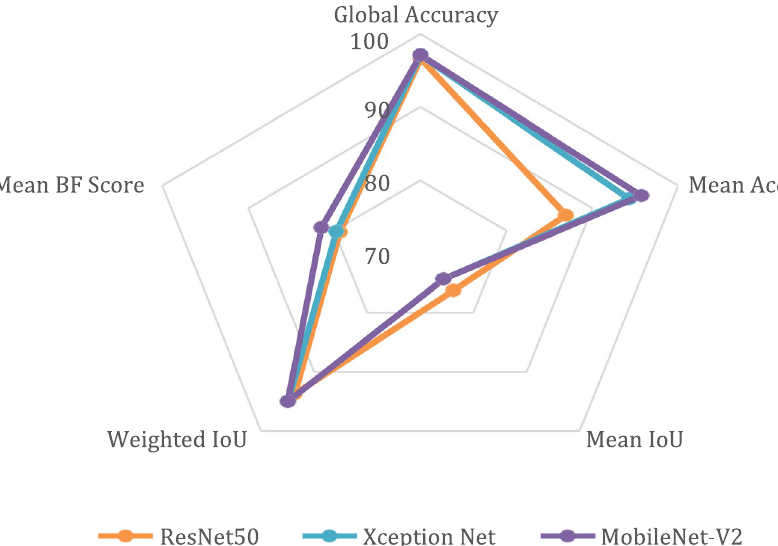
Fig. 13 The radar plot for each network for all the performance metrics for the validation